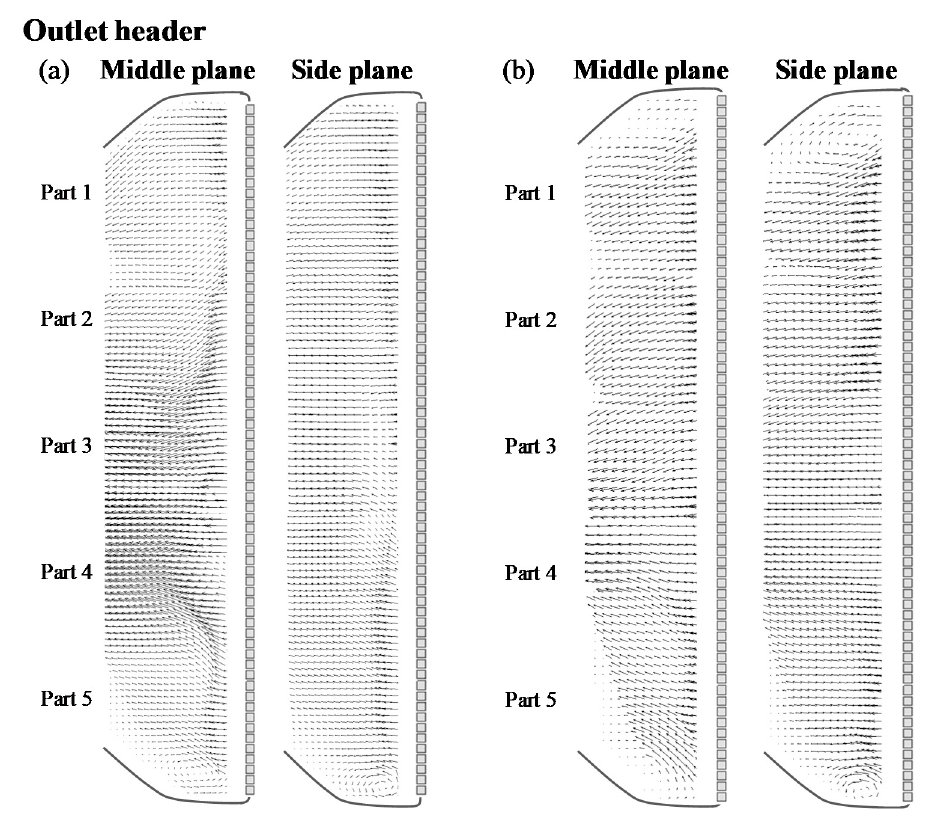
Figure 15. Ensemble average velocity fields in the region near the channel exits in the outlet header: ( a ) in the absence of perforated plate and ( b ) when the perforated plate is installed.